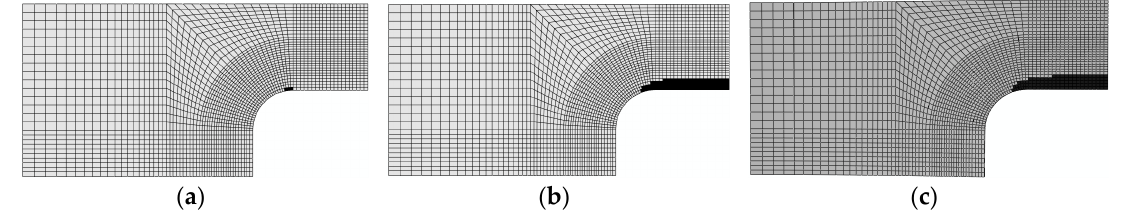
Figure 12. Buckling and kinking damage of repaired fiber (0°): ( a ) 143 kN; ( b ) 178 kN; and ( c ) 213.1 kN.